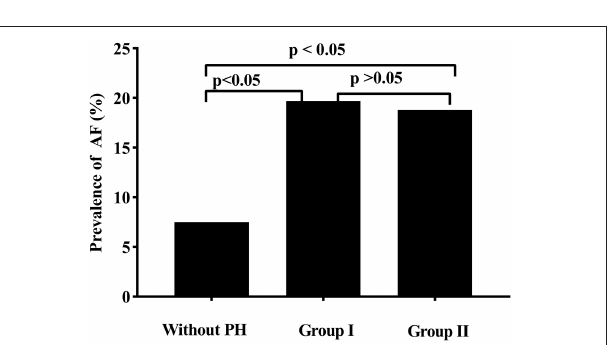
FIGURE 3 | Compared to patients without pulmonary arterial hypertension (PH), patients with PH had a significantly atrial fibrillation (AF) higher incidence. No diffidence in AF prevalence was found between patients with a pulmonary artery systolic pressure (PASP) < 50 mmHg (Group I) and patients with a PASP ≥ 50 mmHg (Group II).